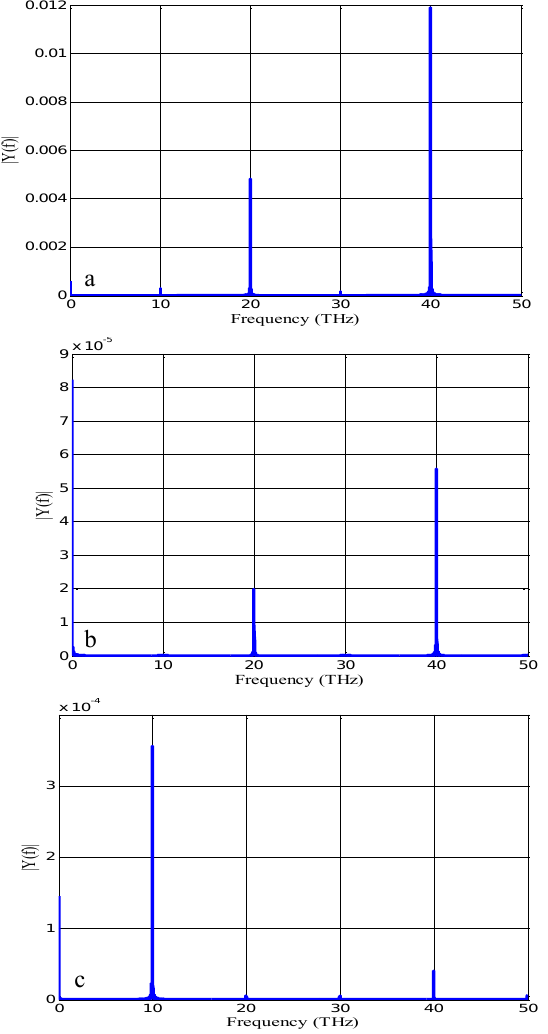
Figure 5: Spectrum of the current on the graphene when it is biased with a) 1+sin(ωt)+100*cos(4ωt) b) 1+.01*sin(ωt)+ cos(4ωt) and c) 1+10*sin(ωt)+ cos(4ωt) where the frequency ω in the bias voltage is 10 THz,